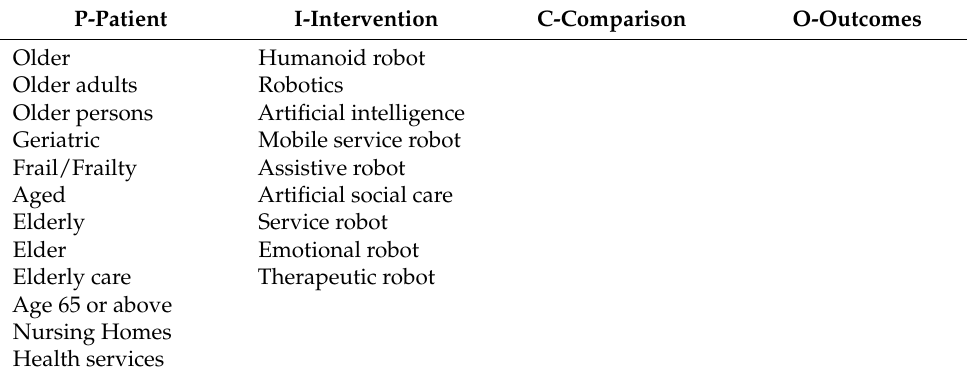
Table 1. PICO framework Use of robots in older people’s